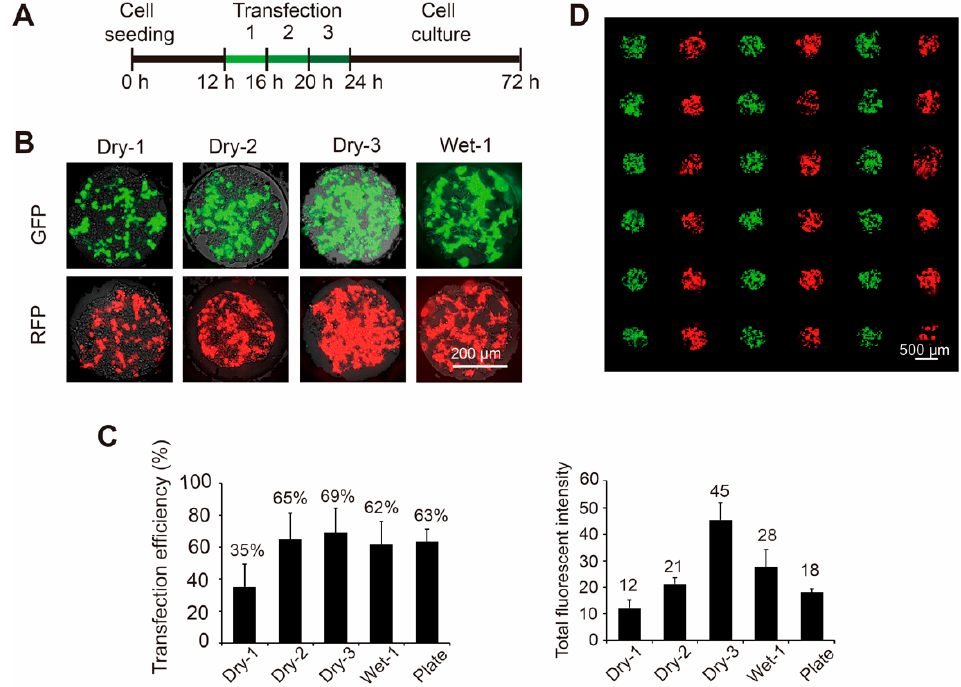
Figure 2. Transfection of plasmids encoding the green and red fluorescent protein (GFP and RFP) genes into 293T cells on the SMAR-chip. ( A ) Timeline of the on chip transfection (dry method). 293T cells were seeded in the microwells. After a 12-h recovery, one to three rounds of transfections were conducted consecutively, followed by two days of culture. ( B ) Typical fluorescent images of the cells transfected with GFP and RFP (upper panel) using the dry method for one (Dry-1), two (Dry-2), and three (Dry-3) rounds or using the wet method for one round (Wet-1). ( C ) Left panel: the transfection efficiencies (left panel) which are calculated as the number of cells with detectable fluorescent signal over the total number of cells in the microwells. Right panel: the total fluorescent signal from the transfected cells data are represented as the mean + standard deviation ( n = 20). ( D ) Merged fluorescent image of 293T cells transfected with GFP and RFP, indicating efficient transfection without cross contamination.